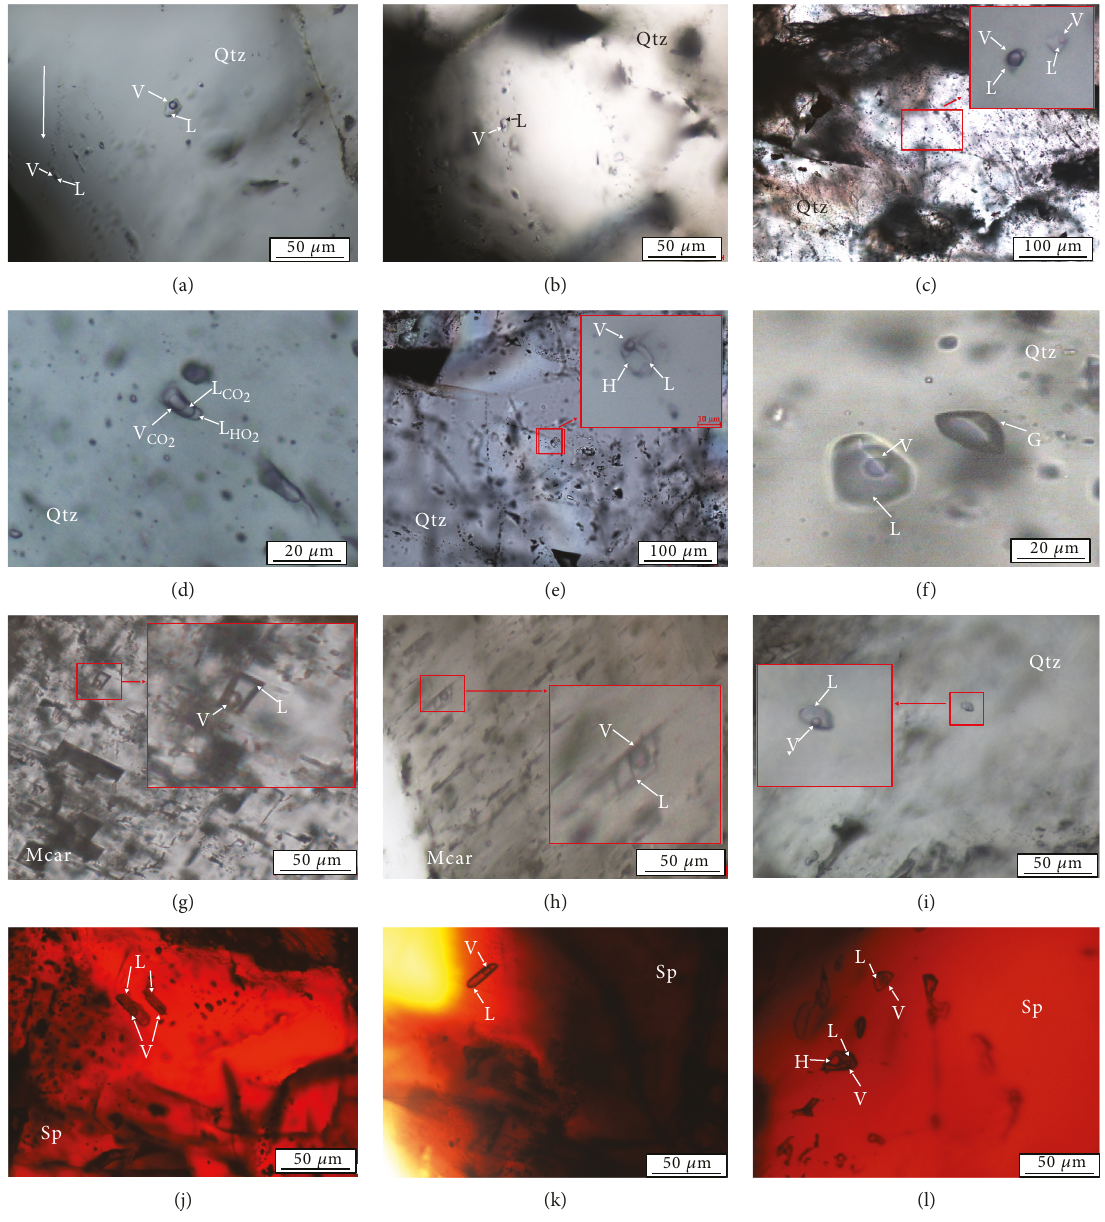
Figure 8: Photomicrographs showing the types and characteristic features of fl uid inclusions (FIs) at the Keyue Sb – Pb – Zn – Ag deposit. (a) Coexistence of the primary and secondary FIs that linearly distribute in assemblage 3 quartz. (b) The pseudosecondary FIs linearly distribute in assemblage 4 quartz. (c) The elliptic V-type FIs in assemblage 3 quartz. (d) The long-columnar C-type FIs in assemblage 3 quartz. (e) The irregular halite-bearing FIs in assemblage 4 quartz. (f) The elliptic G-type FIs in assemblage 3 quartz. (g) The rectangular L-type FIs in assemblage 1 Mn – Fe carbonate. (h) The rhombic L-type FIs in assemblage 2 Mn – Fe carbonate. (i) The L-type FIs isolatedly distribute in assemblage 5 quartz. (j) The long-columnar L-type FIs in assemblage 2 sphalerite. (k) The long-columnar L-type FI inclusions in assemblage 2 sphalerite. (l) The S-type FIs in assemblage 2 sphalerite. Abbreviations are the same as in Figure